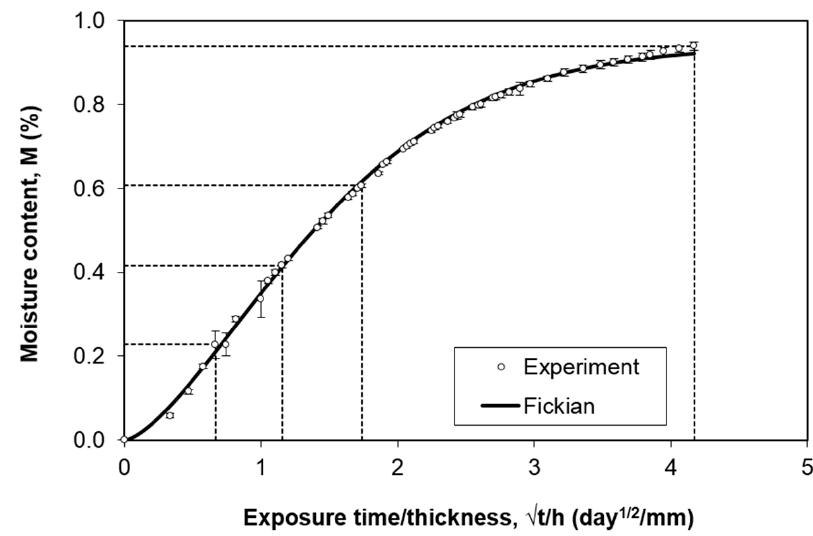
Figure 2. Experimental and fitted moisture absorption curves of the carbon–epoxy composites.